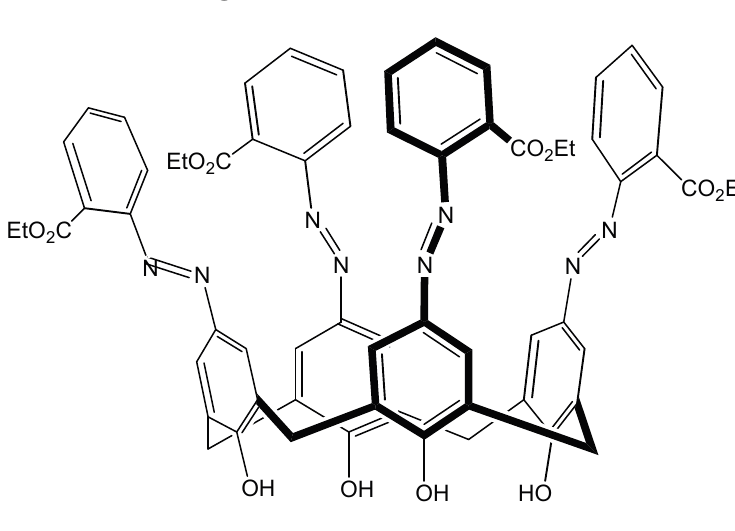
Figure 27. Structure of